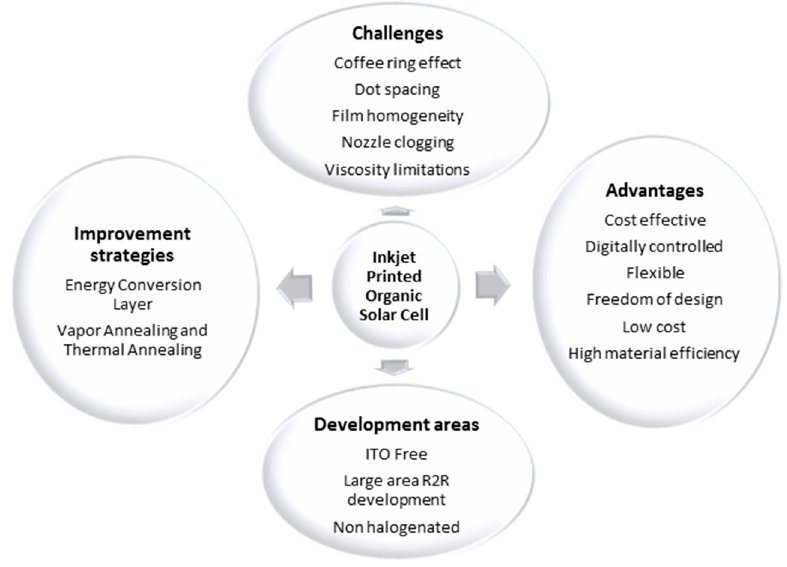
Figure 6. Schematic illustration of advantages, challenges, development areas and improvement strategies of the inkjet-printed OSC [22,102,103,107].